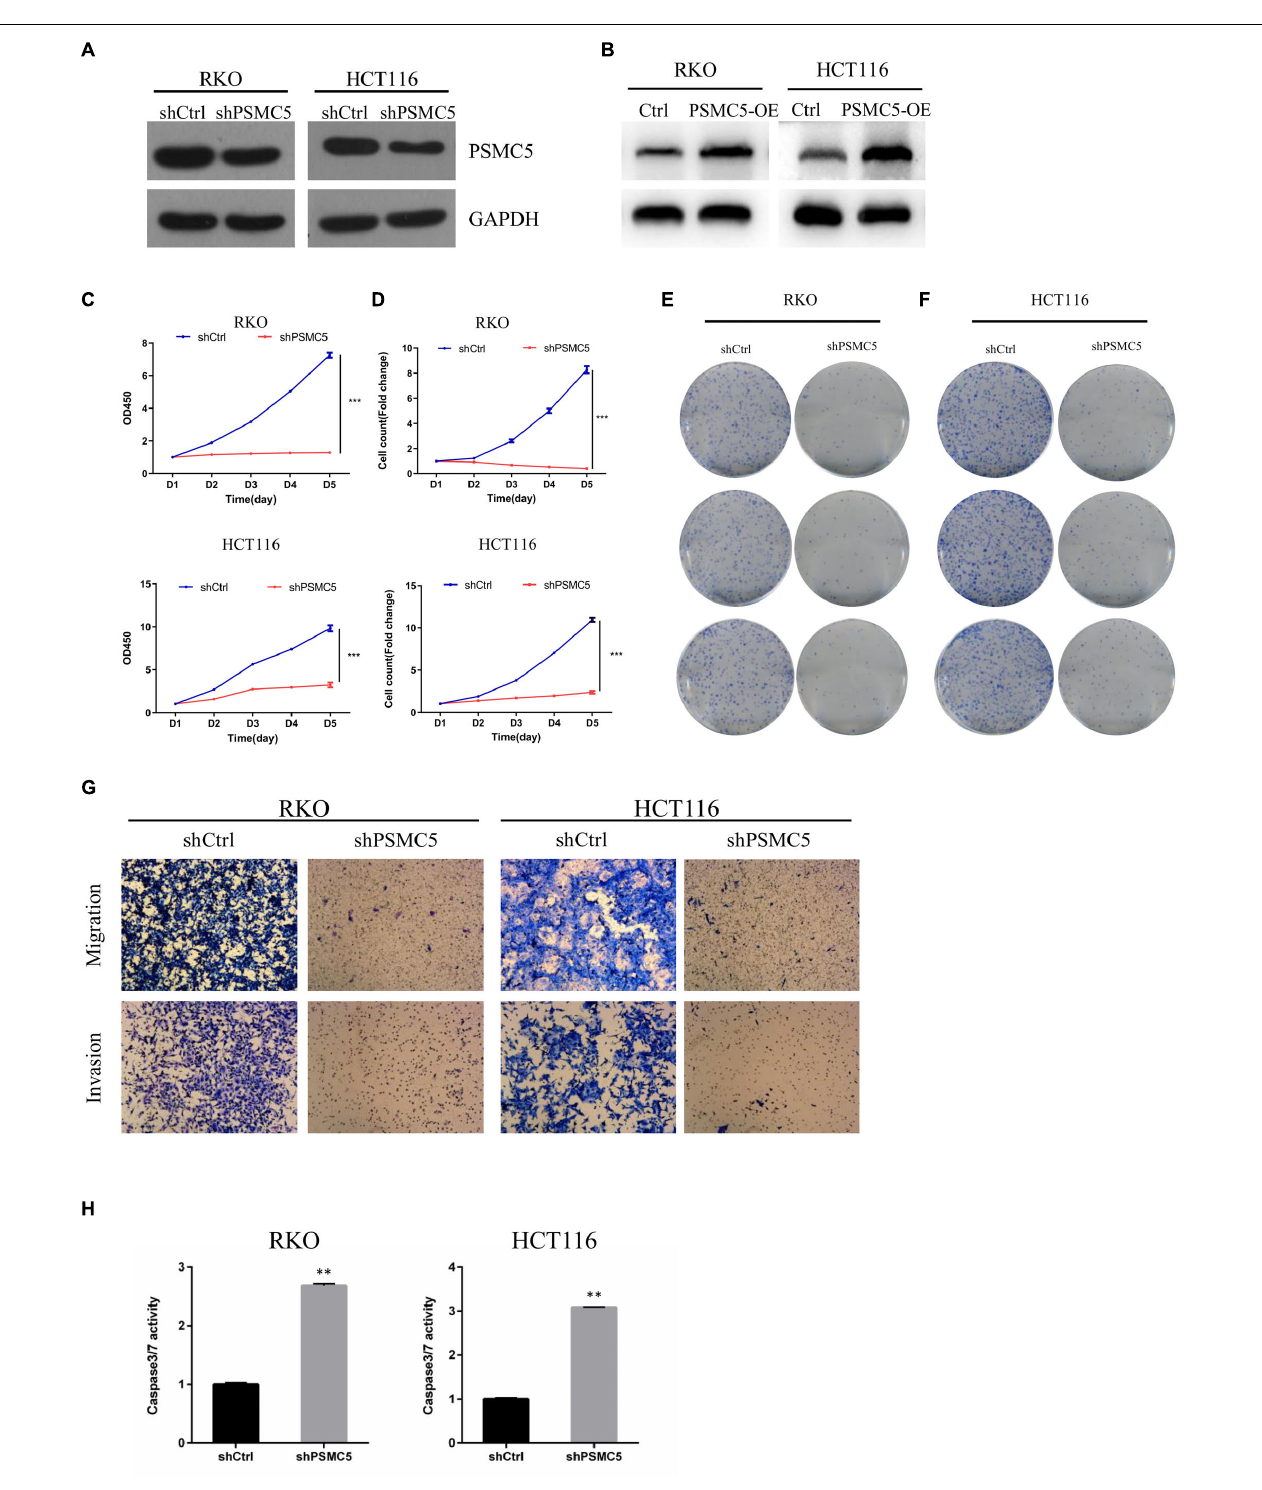
FIGURE 2 | Loss of PSMC5 inhibits the ability of proliferation and invasion of CRC cells. (A,B) The effect of PSMC5 knockdown (A) and overexpression (B) was confirmed by Western blotting. (C,D) growth curve based on MTT assay (C) or cell count assay by the Celigo Image Cytometer (D) ; one-way ANOVA test was used to determine the difference between two groups. *** p < 0.001. (E,F) Colony formation analysis of shPSMC5 and control cells in RKO (E) and HCT116 (F) cell lines. (G) Transwell assay showing the alteration of invasion cell numbers between shCtrl and shPSMC5 cells. (H) The level of caspase3/7 activity of shCtrl and shPSMC5 cells was examined and shown as mean ± sd. p values were calculated by Student’s t -test. ** p < 0.01. CRC, colorectal cancer.